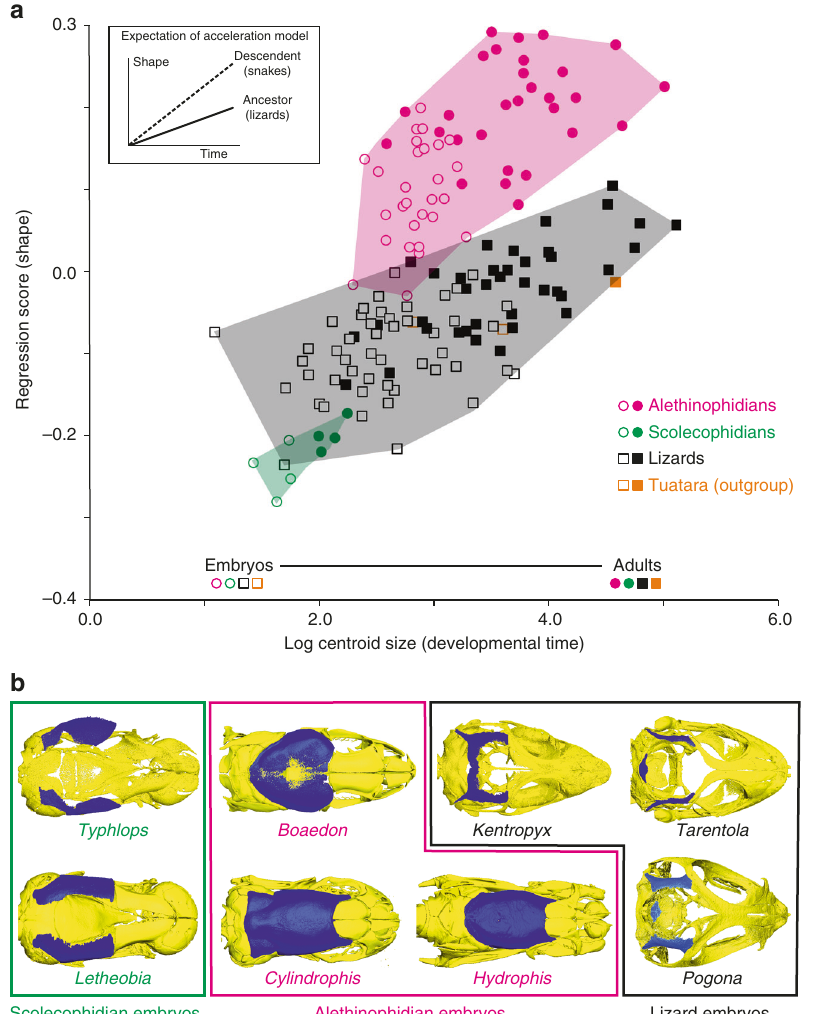
Fig. 6 Ontogenetic and heterochrony analyses. a Regression analysis of 2D shape (regression score) onto log-centroid size for lizard (black squares), scolecophidian (green circles), alethinophidian (red circles), and tuatara (outgroup, orange squares) ontogenies. Embryos are shown as open circles (for snakes) or squares (for lizards and outgroup). The top left inset shows the expected regression lines for an acceleration model of heterochrony. b Dorsal views of 3D-rendered skulls from scolecophidian ( Typhlops and Lethobia ), alethinophidian ( Boaedon , Cylindrophis , and Hydrophis ), and lizard ( Kentropyx , Tarentola , and Pogona ) stage 10 embryos, showing the ossi fi cation levels of the different skull bones; delayed ossi fi cation of the parietal bone (blue color) in all scolecophidians and lizards is